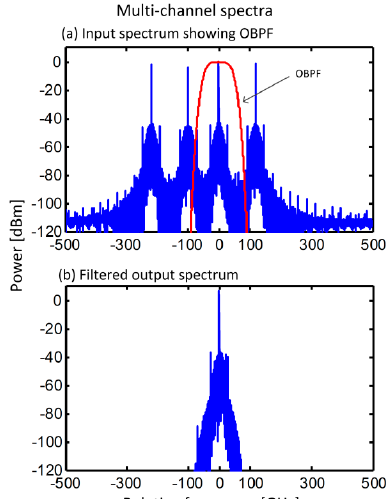
Figure 8. ( a ) SOA input spectrum showing four wavelength channels modulated with PAM4 data. The average power per channel is 1 mW. The BER estimates are performed on the channel that has been filtered out using the OBPF shown in red. ( b ) Spectrum of the filtered signal at the SOA output showing strong rejection of neighboring channels.